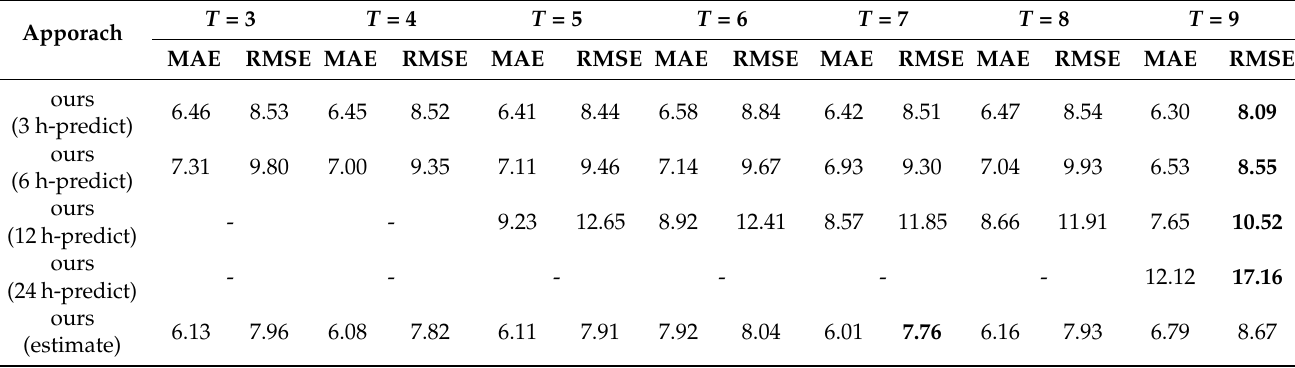
Table 4. Estimation and prediction RMSE and MAE of our method. In our prediction experiment, the length of the input time series must be greater than the predicted length. Therefore, we put a ’-’ in any position to represent an unpredictable situation.